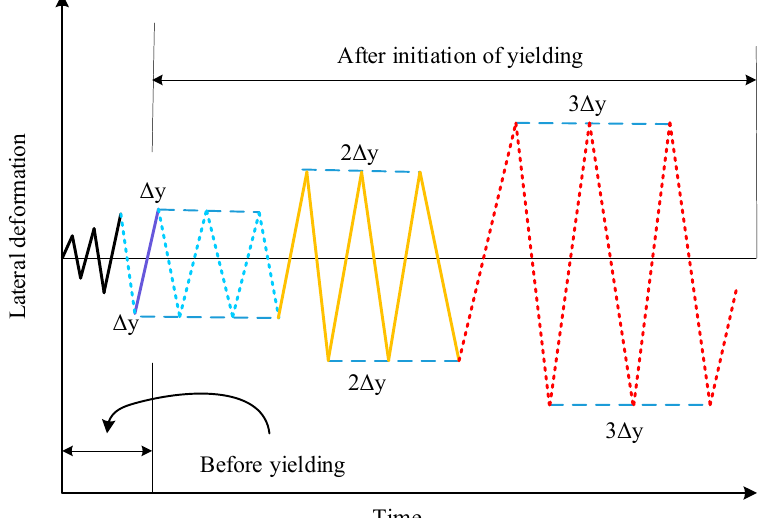
Figure 5. The cyclic load